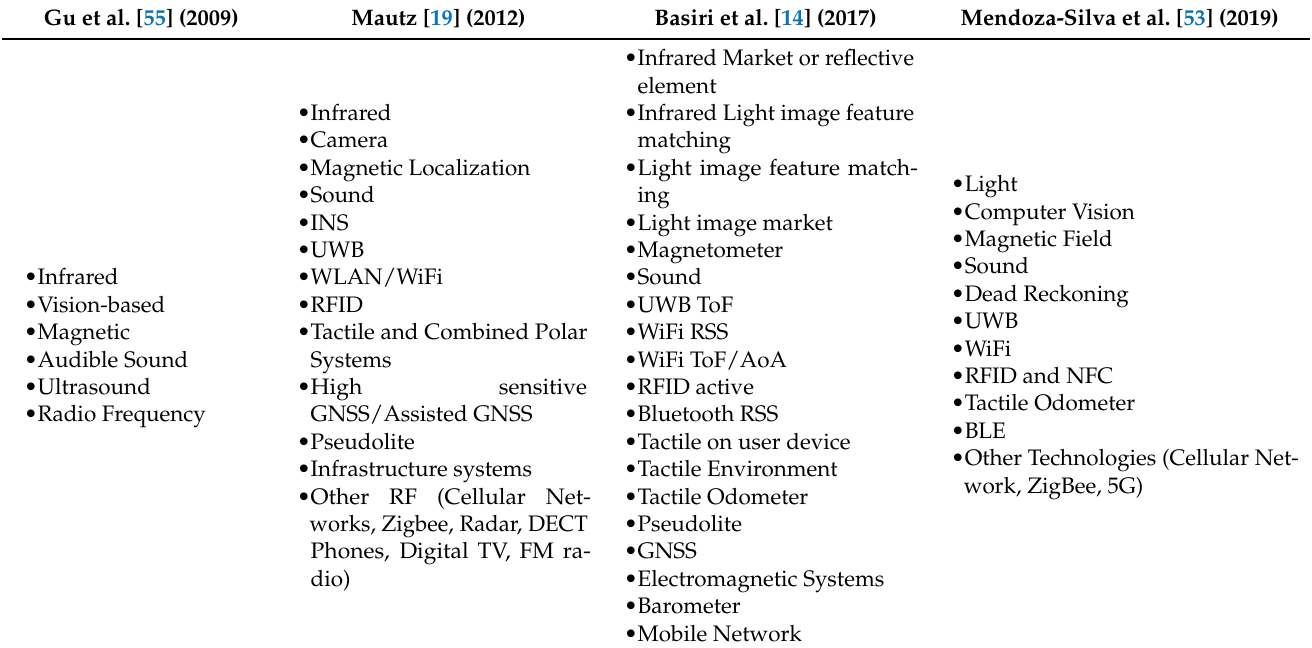
Table 1. Different indoor positioning technologies classification